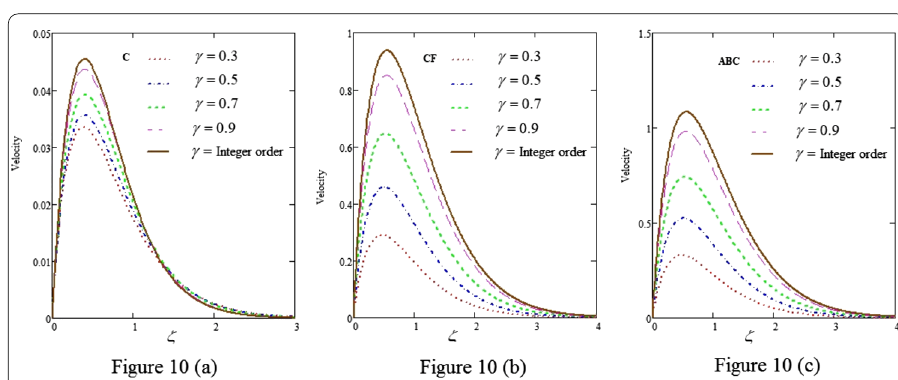
Figure 10 ( a , b , c ). Velocity curves for C, CF and ABC for various values of γ approaching to integer